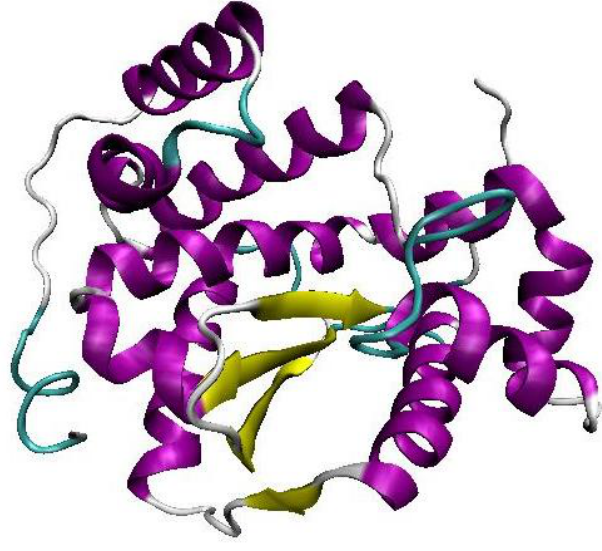
Figure 1. The model with the best Discrete Optimized Potential Energy (DOPE) scoring selected as our built model for KPN_03358. Alpha helix and beta sheet secondary structures are represented in purple and yellow, respectively. The graphic was generated using Visual Molecular Dynamics (VMD) visualization tool